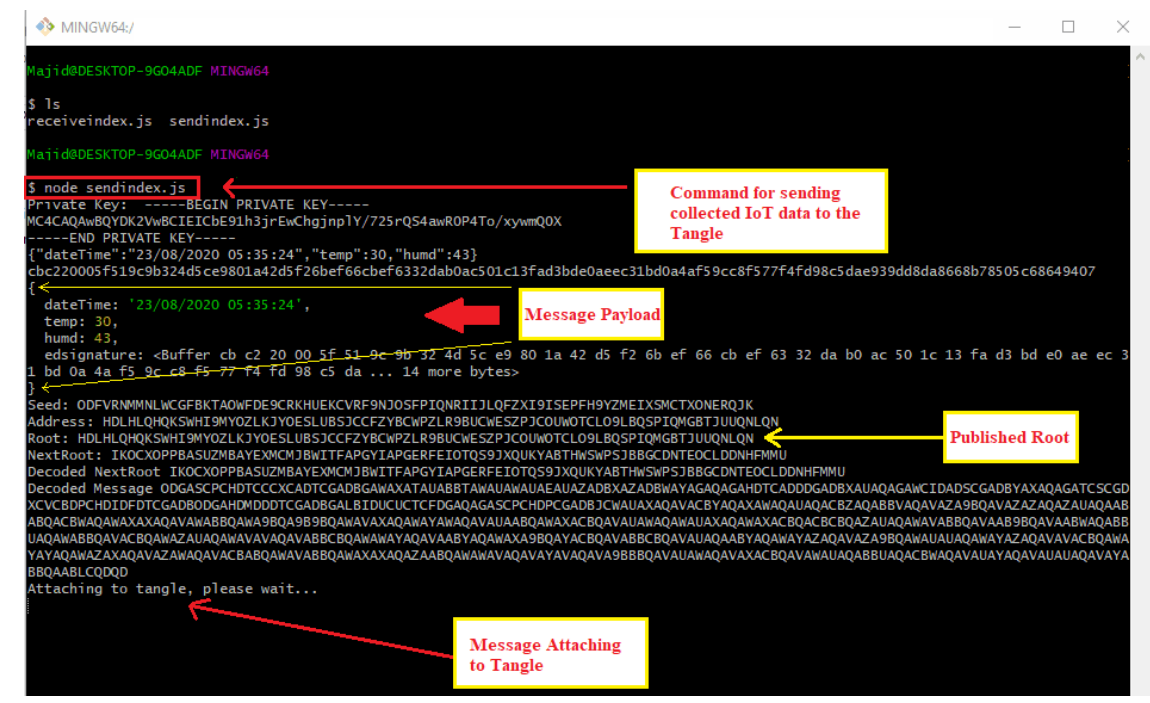
Figure 10. Attaching the first message payload to the Tangle.